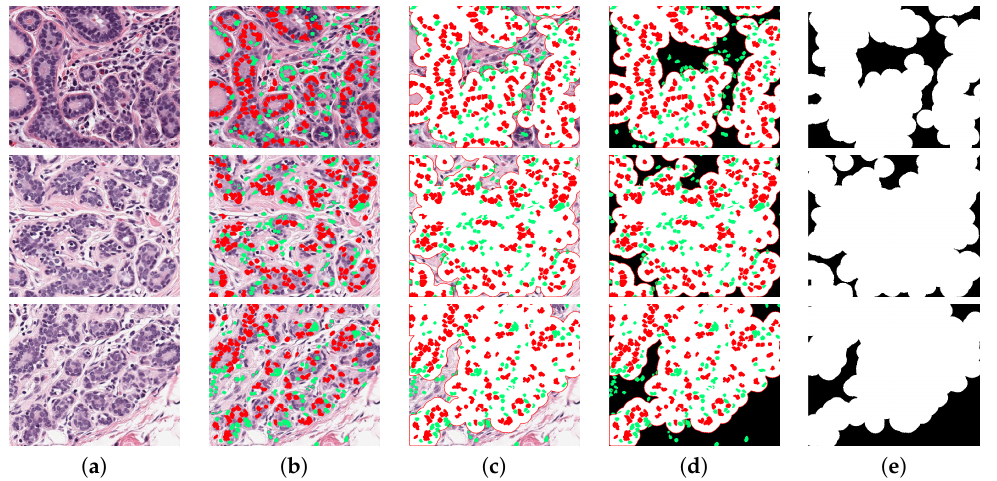
Figure 11. Three cases where the TC was incorrectly calculated. Each row corresponds to a patch with incorrect TC. Column ( a ) illustrates the original image, and columns ( b – e ) show the step by step process to assess cellularity. ( b ) Corresponds to the segmented image and classified into benign (green) and malignant (red). Columns ( c , d ) show expanded region of malignant cells. Column ( e ) corresponds to cancer cell region in white, used to compute TC. Three worst cases correspond to a TC of zero; this means there would not be any malignant cell and TC image must be completely black. Several cells were miss classified which yields to a TC wrong assessment. Estimated TC values are: 0.75, 0.81, and 0.75, instead of